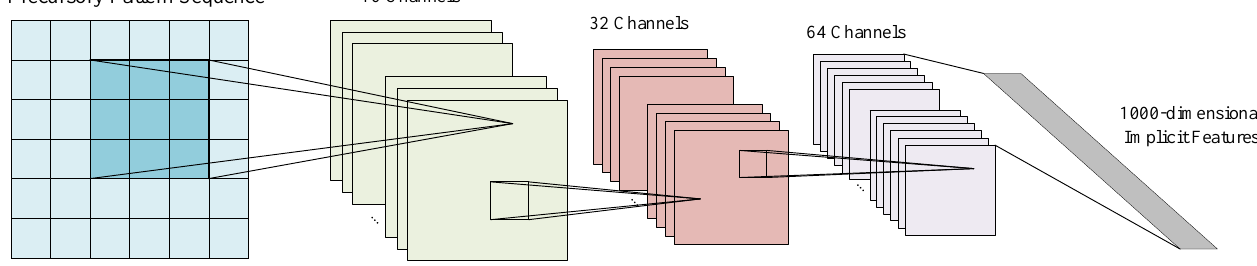
Figure 3. Data-driven feature extraction network based on convolutional neural